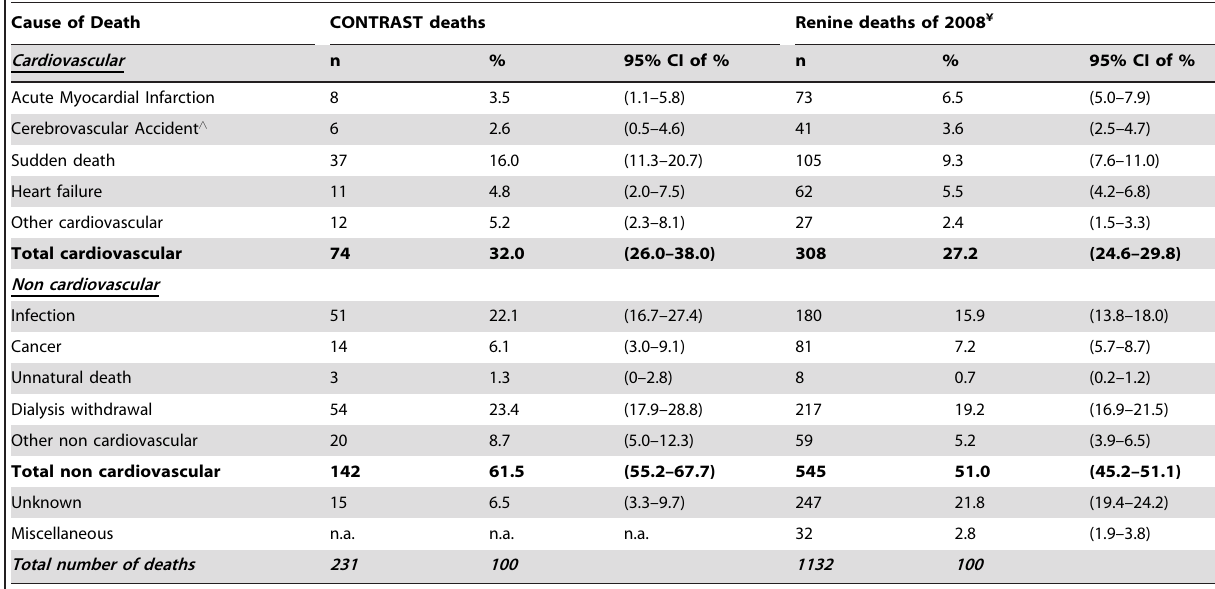
Table 2. Causes of death in CONTRAST and